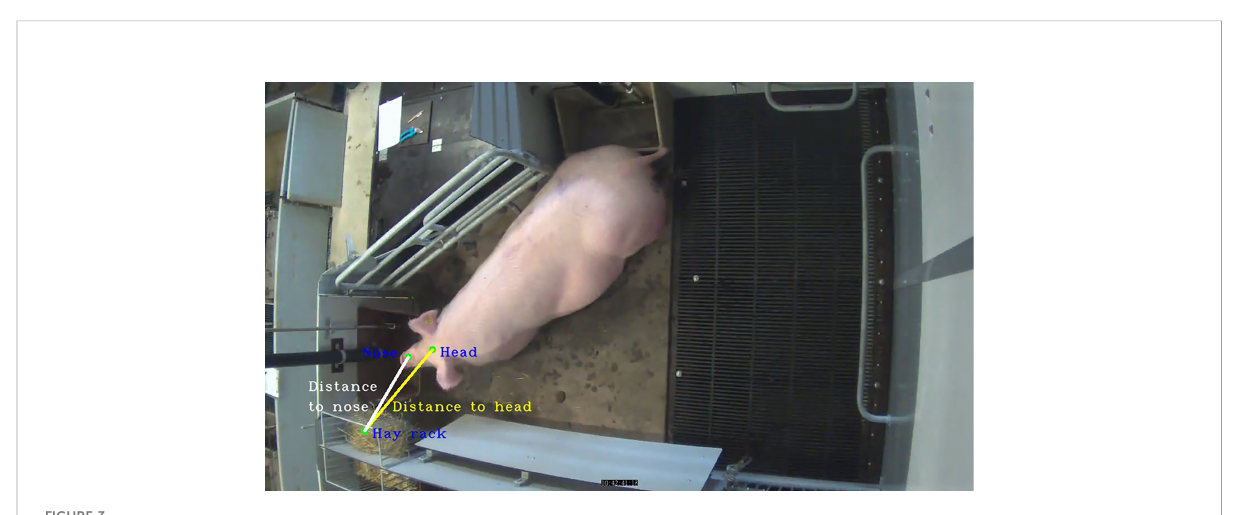
FIGURE 3 Distance from nose to rack and from head to rack.